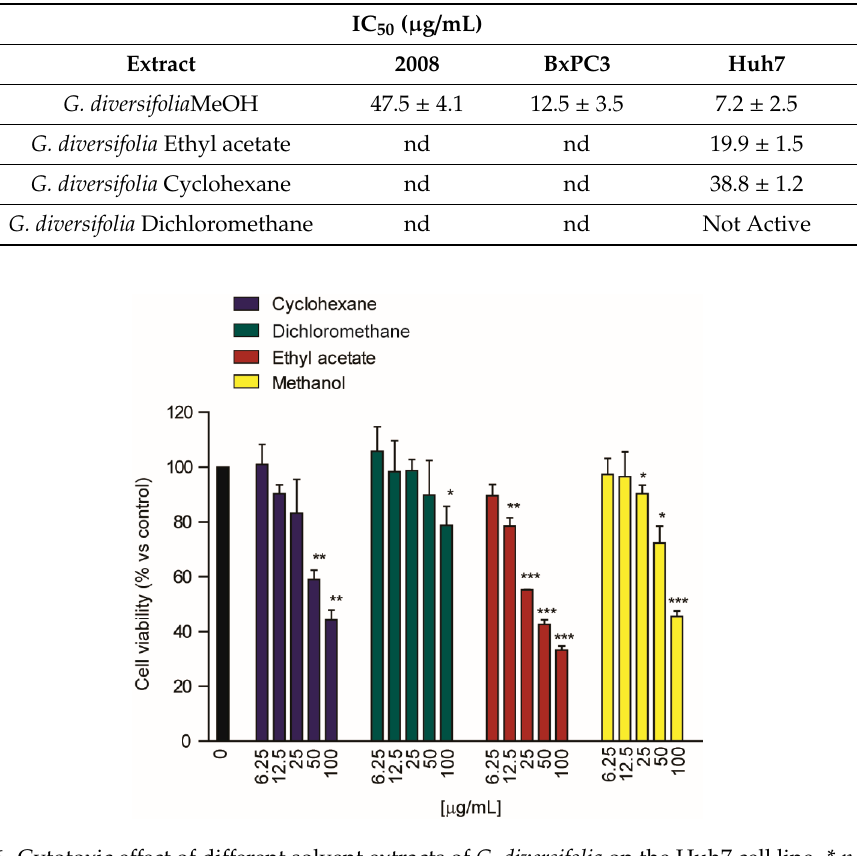
Figure 5. Cytotoxic effect of different solvent extracts of G. diversifolia on the Huh7 cell line. * p < 0.05; Figure 6. Cytotoxic e ff ect of di ff erent solvent extracts of G. diversifolia on the Huh7 cell line. * p < 0.05; ** p < 0.01; *** p < 0.001. Student’s t-test. ** p < 0.01; *** p < 0.001. Student’s